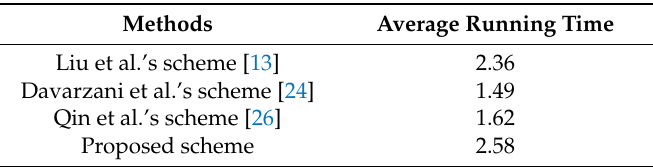
Table 1. The average running times of different PIH methods.